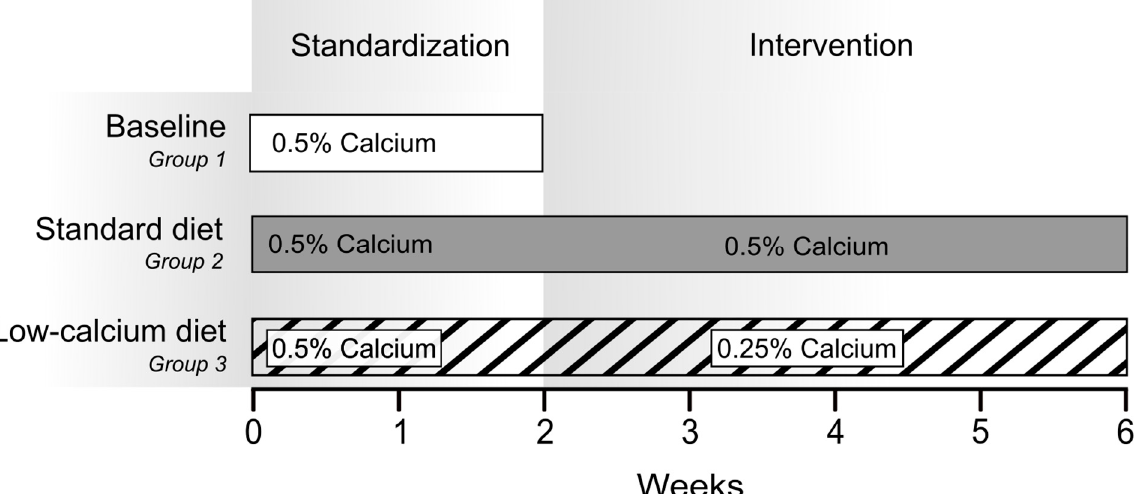
Figure 5. Study experimental organization. All animals received the standard-diet for two weeks. Animals of group 1 (n = 18, empty bar) were sacrificed to obtain baseline values. Animals in group 2 were maintained on standard-diet (n = 20, gray bar), animals in group 3 were switched to a low-Ca-diet (n = 20, hatched bar). Blood samples were taken weekly. Spot urine and feces were collected after one, three and five weeks. 24 h urine and feces were collected after two, four and six weeks.